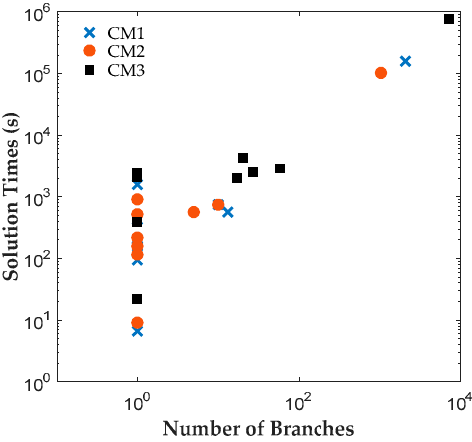
Figure 8. Change in solution times with the number of branches needed to solve CM1, CM2 and CM3. Please note most problems are solved at the root node, and when branching is required to solve the problem, the linear dependency of solution time to number of branches required to solve the problem is evident from this figure.